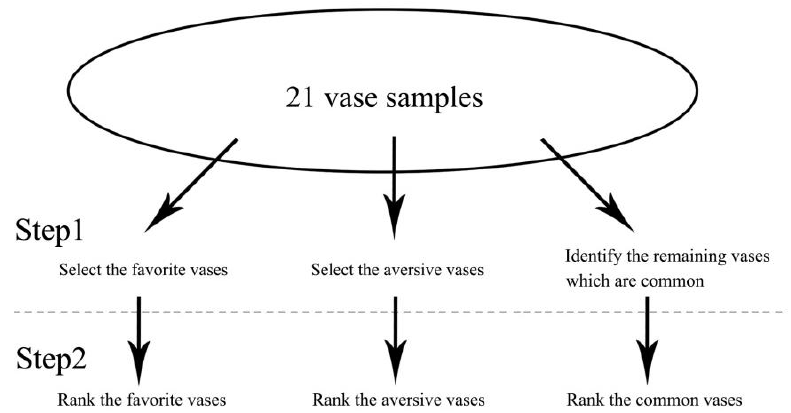
Figure 6. Structure of preferences questionnaire.